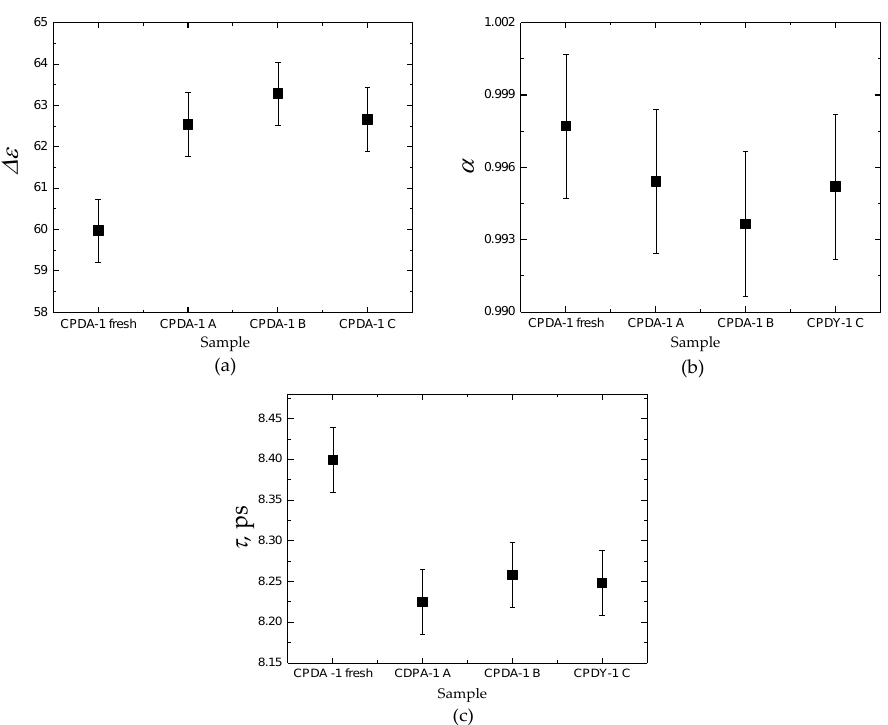
Figure 2. Comparison of dielectric parameters Δ ε ( a ), α ( b ), τ ( c ) for fresh CPDA-1 with storage medium for three samples A, B, and C. Each datum is mean ± SEM from six repeated measurements .